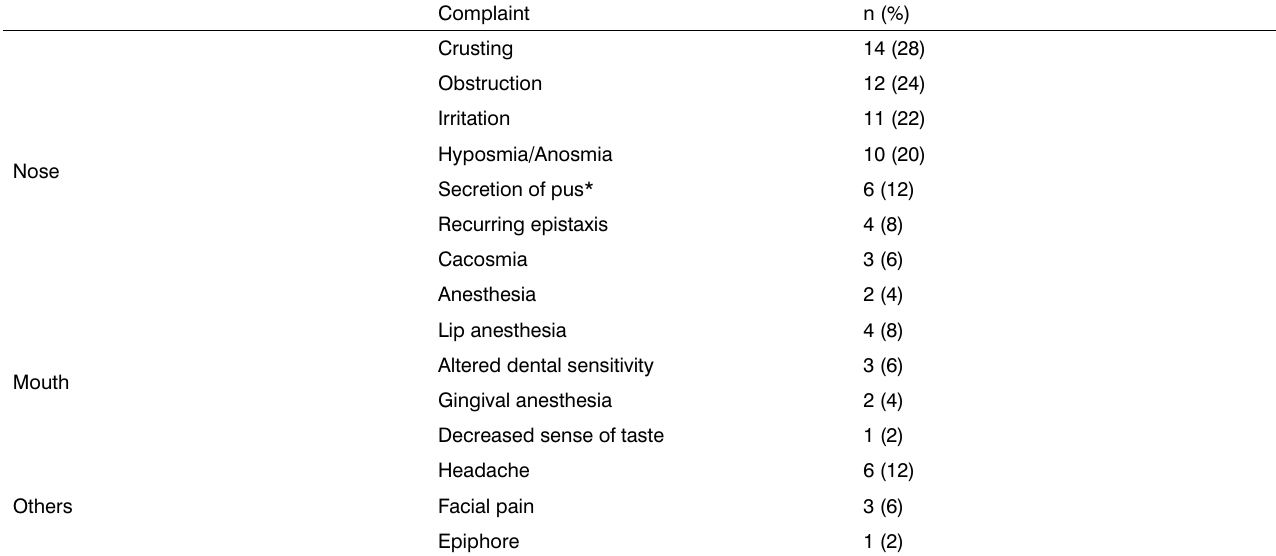
Table 1. Complaints pertaining to oronasal complications in patients undergoing transsphenoidal surgery.